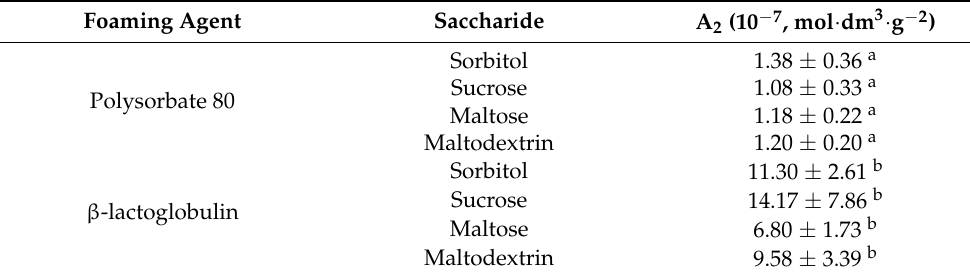
Table 1. Second virial coefficient A 2 of polysorbate 80 and β -lactoglobulin solutions in the appearance of different saccharides at 20 ◦